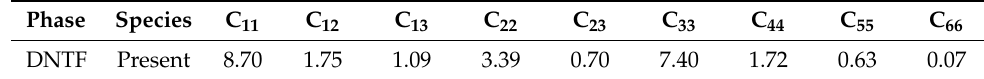
Table 2. The calculated elastic constants of DNTF at 0 GPa. Phase Species DNTF